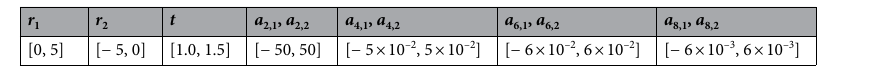
Table 1. Value ranges of aspheric surface coefficients a 2 , a 4 , a 6 , a 8 and